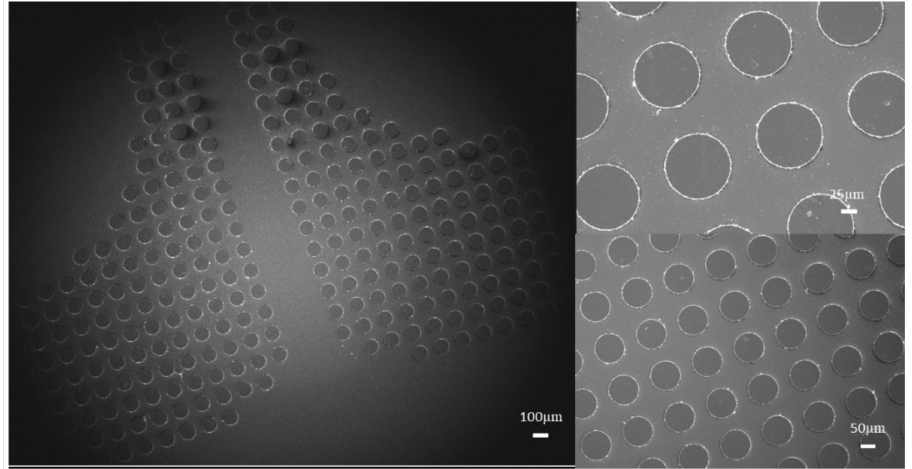
Figure 5. SEM images of the epoxied green QDCF with well-ordered homogeneous